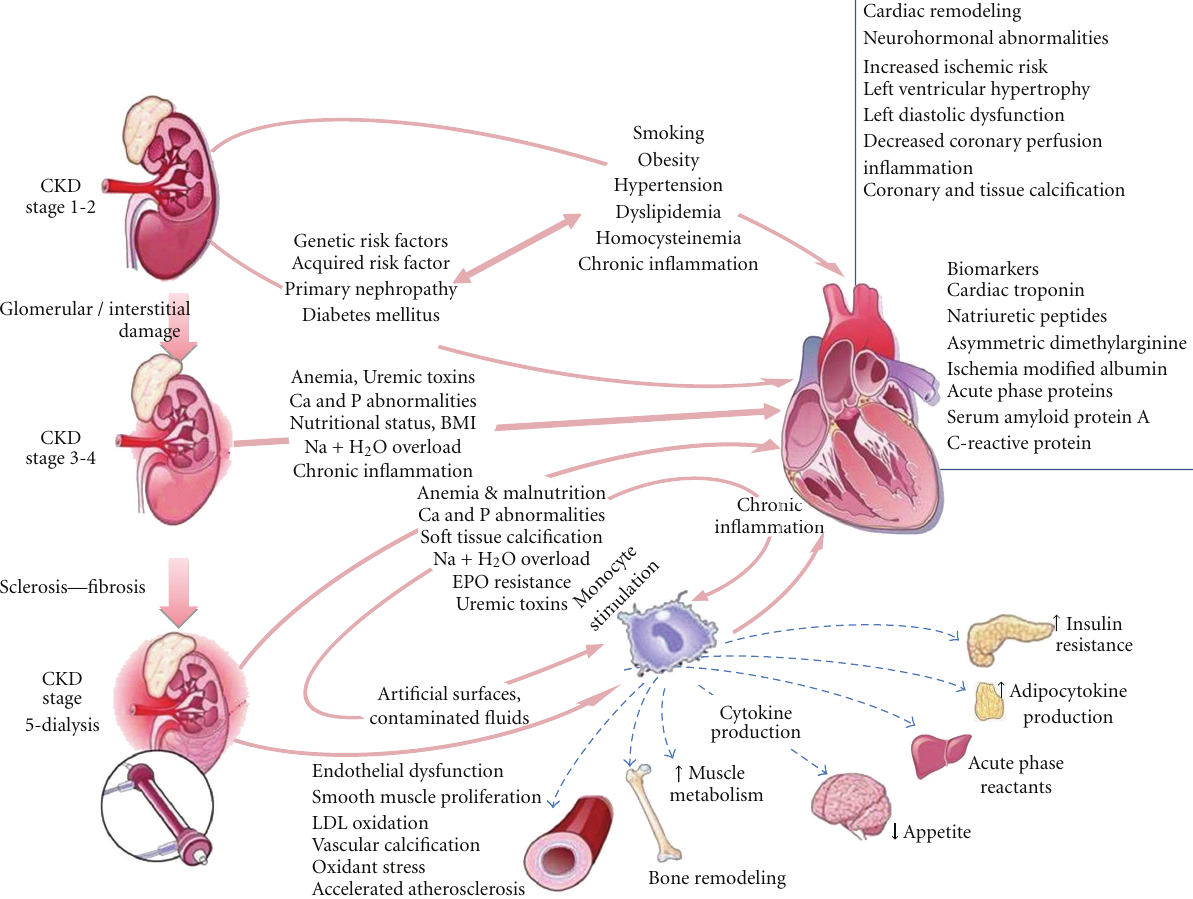
Figure 2: Complex pathogenesis of chronic kidney disease (CKD) and cardiovascular disease (CVD) [50].